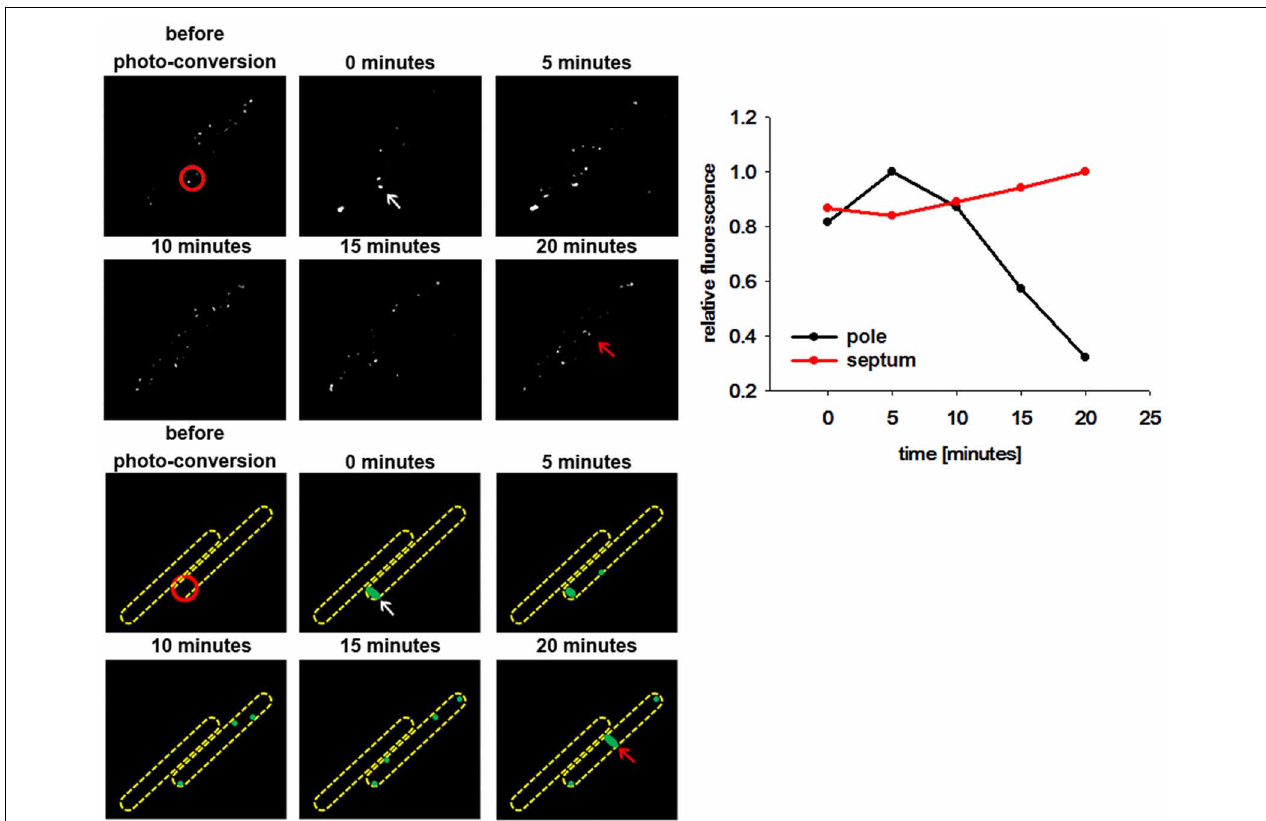
FIGURE 3 | DivIVA-PA-GFP is dynamically recruited from the cell pole to the septa. DivIVA-PA-GFP fluorescence was imaged before photo-activation using DIC and FITC specific filters. Photoactivation was performed using a laser at 405nm (red circle). After photoactivation DivIVA-PA-GFP (white arrow) is localized at the cell pole. Although, the signal gets more diffuse over time, accumulation at a new septum after